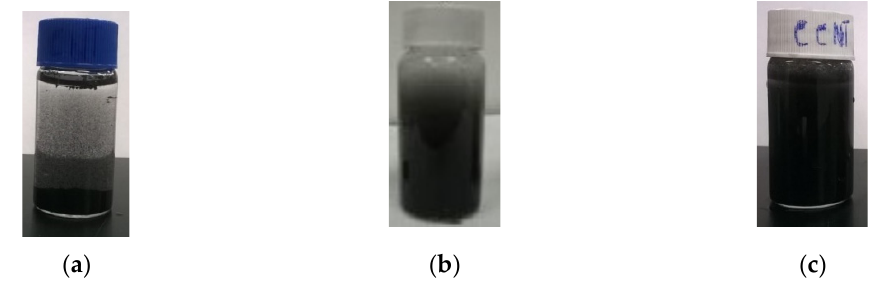
Figure 2. Dispersion of carbon nanotubes (CNTs) in water mixture: ( a ) Bare CNTs (Sample DM, direct mixing method); ( b ) Surface modified CNTs (Sample SM, surfactant method); ( c ) co-polymer coated CNTs (CCNTs) (Sample A, copolymer method) (Note: The inferences were made based on visual observations only. The visual observations clearly demonstrate the ability of the modified tapioca starch to disperse CNTs effectively.).